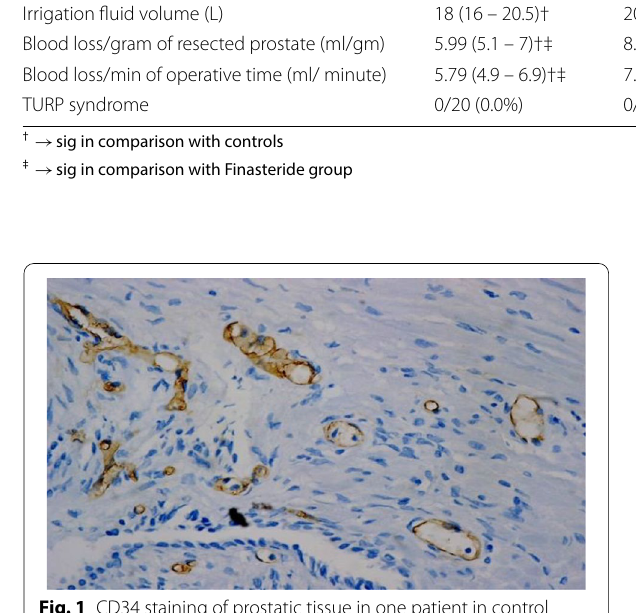
Fig. 1 CD34 staining of prostatic tissue in one patient in control group: showing quantitative increase in microvessel density